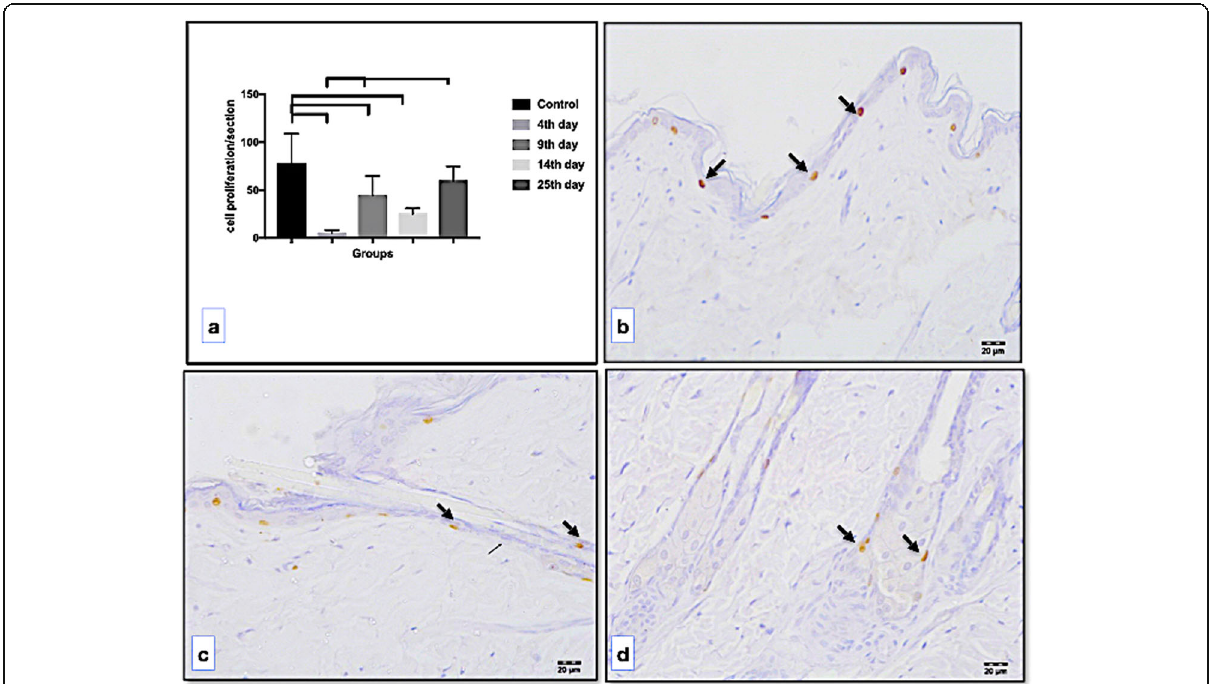
Fig. 4 Number of proliferation cells per section in the epidermis ( a ) and representative images for 5-bromo-2-deoxyuridine-positive nucleus (arrows) in the epidermis ( b ), in the hair follicle ( c ), and at the base of a sebaceous gland ( d